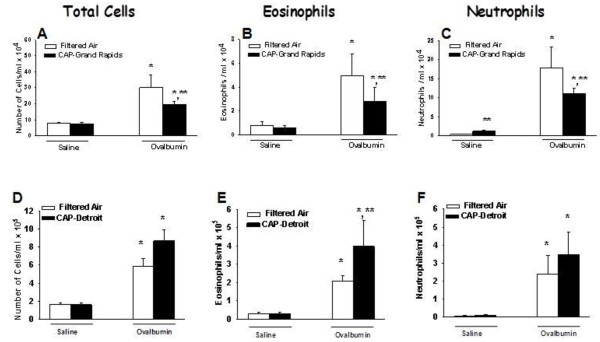
Effect of CAPs exposure on BALF cellularity. Animals were sensitized and challenged with saline (white bars) or with OVA (black bars) immediately prior to exposure to CAPs in Grand Rapids (A, B, C), or Detroit (D, E, F). Twenty four hours after the CAPs exposure bronchoalveolar lavage fluid was collected and total cells, eosinophils, and neutrophils were enumerated as described in Methods. * = significantly different from respective group challenged with saline; ** = significantly different from respective group exposed to filtered air; n = 8/group; p < 0.05.